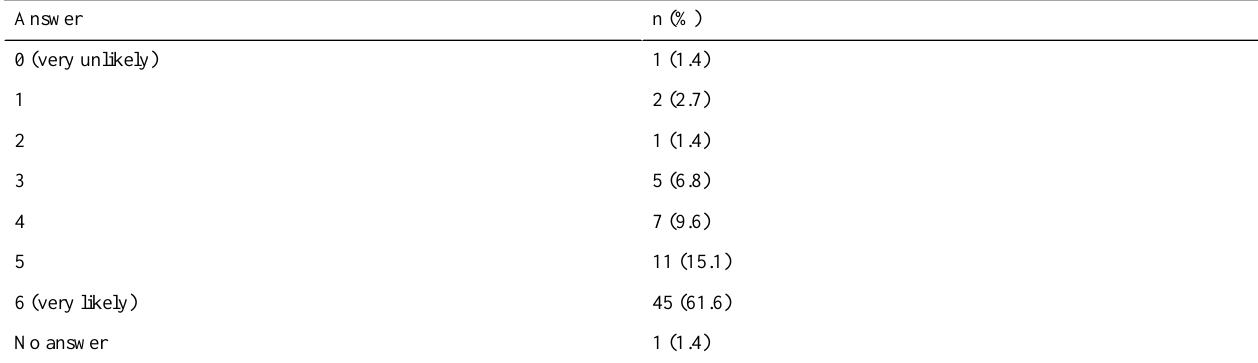
Table 13. Parents’answers about the probability of them joining the community (N=73).